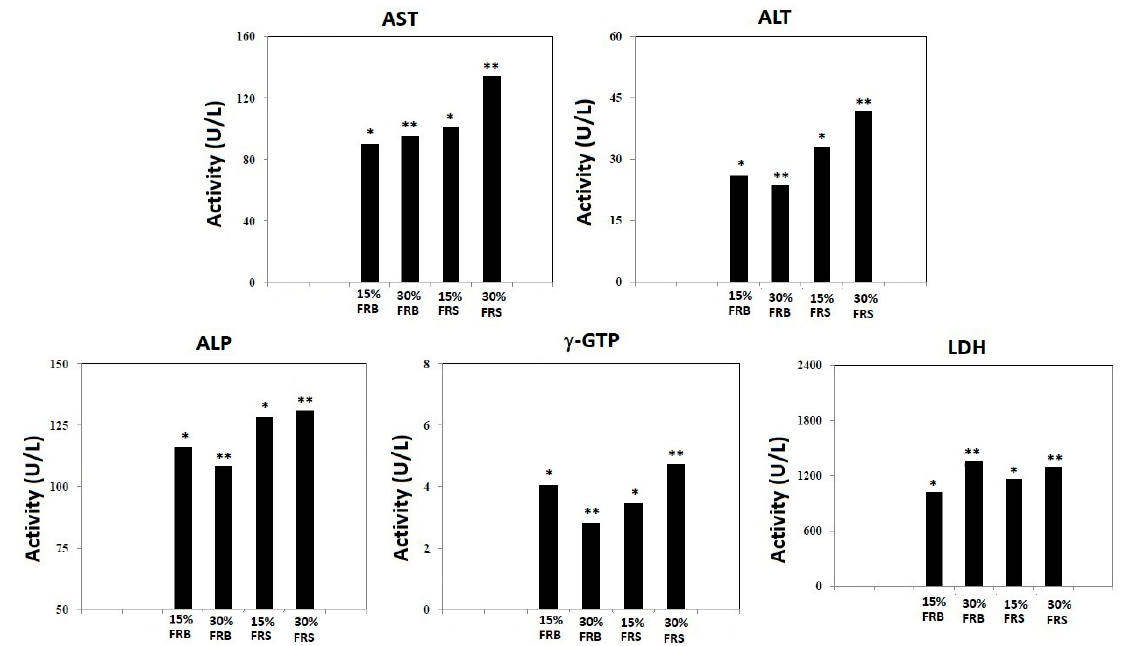
Figure 2. The effects of fermented rice bran (FRB) and fermented rice germ and soybean (FRS) on serum levels of aspartate aminotransferase (AST), alanine aminotransferase (ALT), alkaline phosphatase (ALP), γ -glutamyltranspeptidase ( γ -GTP) and lactate dehydrogenase (LDH). * Statistical significance at p < 0.05. ** Statistical significance at p < 0.05.